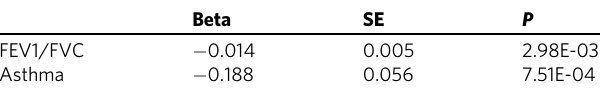
Fig. 9 Paclitaxel (Pax) mitigates perinatal high-fat diet (HFD)-associated bronchial and vascular remodeling. A The offspring of HFD- or standard diet (SD)-fed dams received an intravenous (i.v.) administration of vehicle or Pax, a FoxO1 activator, at postnatal day 50 (P50). All endpoints were assessed at P70. B – D Body weight ( B ), white adipose tissue (WAT) ( C ), and WAT relative to body weight ( D ). E Representative immuno fl uorescent lung images for α - smooth muscle actin ( α SMA, red) and FoxO1 (green); the quantitative FoxO1 intensities per de fi ned area (10 µ m 2 ) are displayed. F Respiratory airway resistance. G Analysis of the bronchial SMC (bSMC) layer in bronchi (diameter: 150 – 250 µ m). H , I Complete microvascular muscularization (20 – 100 µ m) ( H ). Right ventricular weight relative to body weight ( I ). J , K Representative immuno fl uorescent lung images for α SMA (red) and Ki67 (green, proliferation); the number of Ki67 + nuclei relative to total nuclei of α SMA-positive cells in bronchi (diameter: 150 – 250 µ m) ( J ) and microvessels